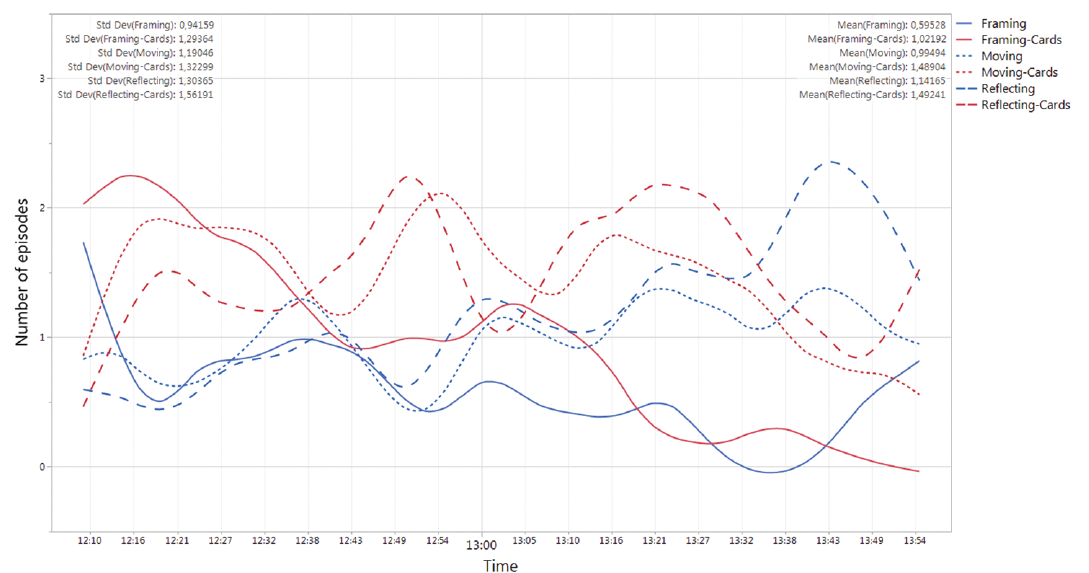
Figure 7. Summary of episodic activity for all